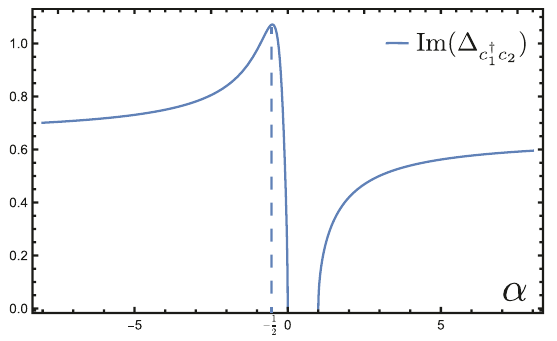
c 2 i . It reaches its maximum 1 i